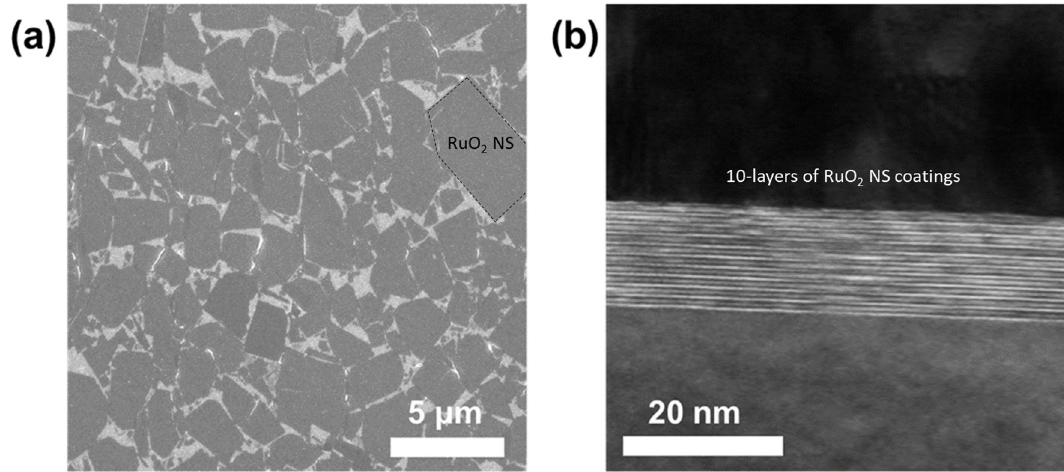
Figure 2. Characterization of the deposited RuO 2 NS films. ( a ) FE-SEM image of the deposited single-layered RuO 2 NS films. Dark regions are the RuO 2 nanosheets. ( b ) Cross-sectional HR-TEM image of 10-layered RuO 2 NS films.